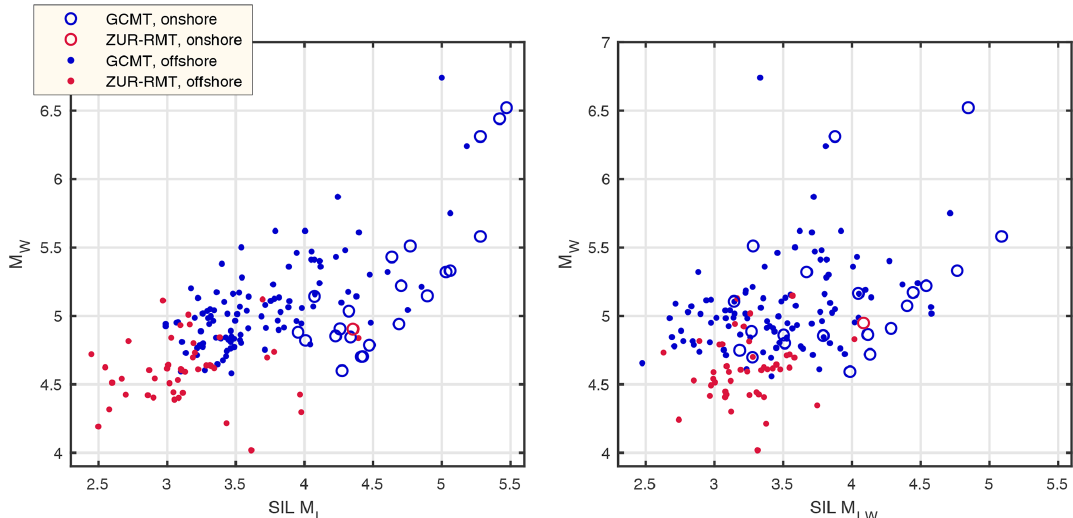
Figure 4. Moment tensor modelled magnitudes ( M w ) and two types of local magnitudes computed by the SIL system (see Sect. 2.2.1). Earthquakes in the calderas Bárðarbunga and Katla have been excluded, but apart from that all events with both SIL and M w magnitudes are included, 24 onshore and 146 offshore. The ZUR-RMT M w values were computed by the Swiss Seismological Service 2000–2005.